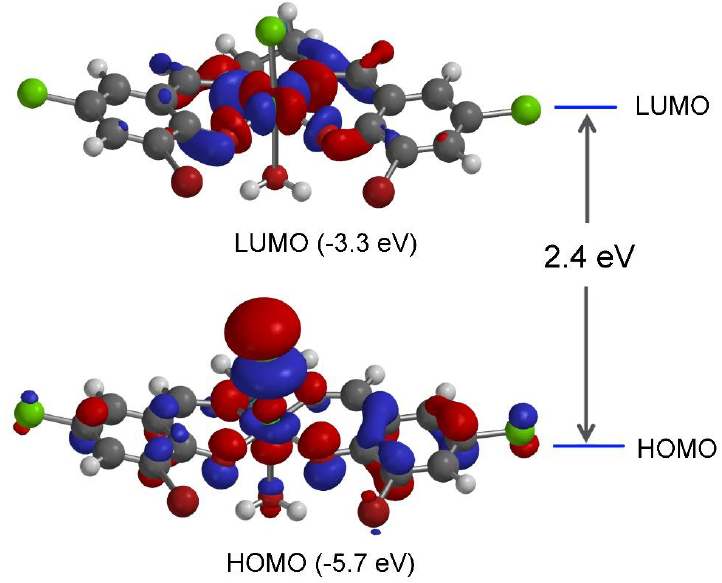
Figure 3. The overlay view of experimental structure and optimized structures of 1 are given in black and red, respectively. Hydrogen atoms have been omitted for clarity.